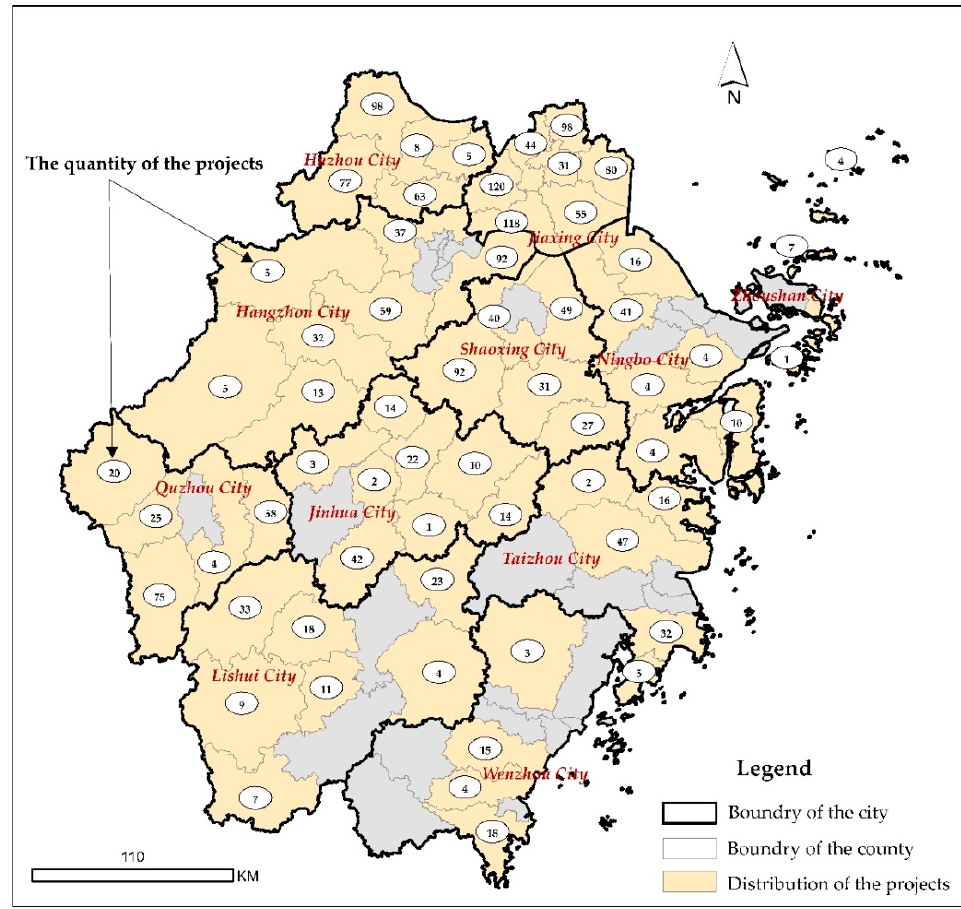
Figure 2. Distribution area and quantity of the increasing versus decreasing balance projects in Zhejiang province.